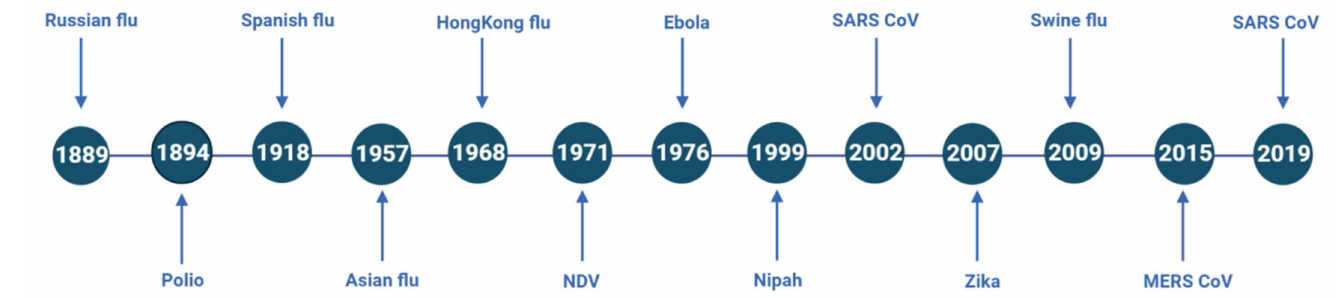
Figure 5. Chronological representation of pandemics that occurred in the